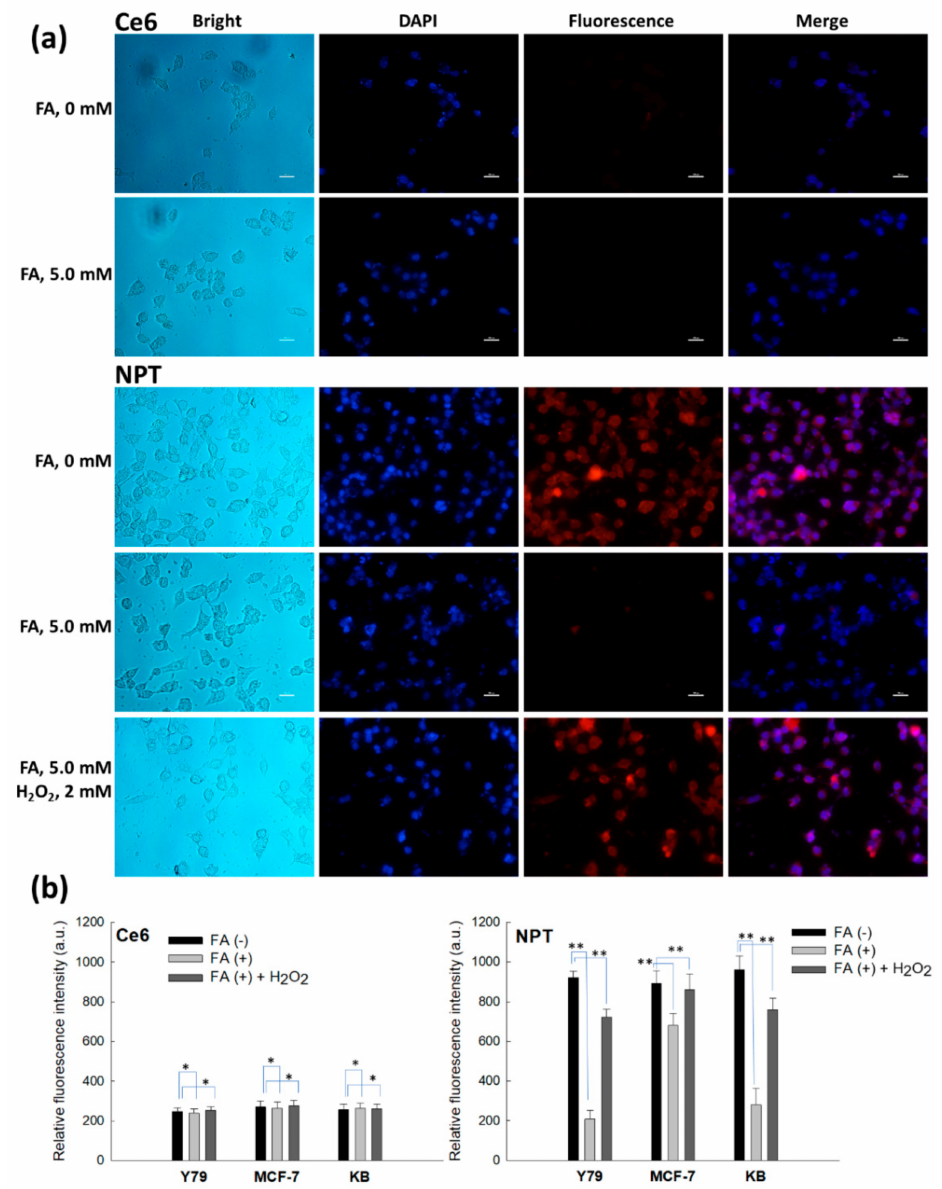
Figure 8. Fluorescence observations of KB cells ( a ) and intracellular Ce6 uptake against various cancer cells ( b ). FA (5.0 mM) was pretreated to the KB cells 30 min before treatment of Ce6 or nanophotosensitizers. For H 2 O 2 (2 mM) treatment, Ce6 or nanophotosensitizers were treated to cells, and then H 2 O 2 was added to the medium. Ce6 concentration was 2 µ g/mL. Bar = 20 µ m. *, ** p <